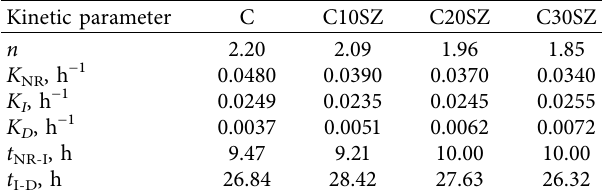
Table 5: Kinetic parameters of hydration in the cement-saturated zeolite system.